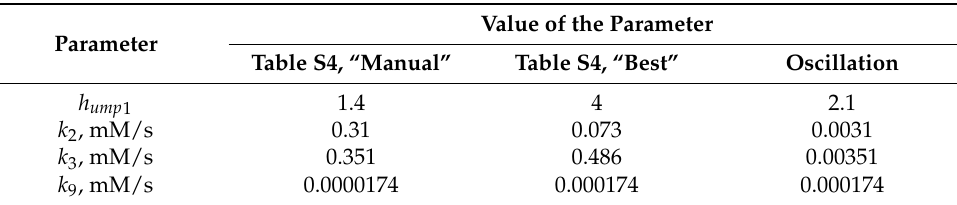
Table 1. Parameters of the model (1), which affect the occurrence of oscillations in concentrations of metabolites in the pyrimidine biosynthesis system, and their values.